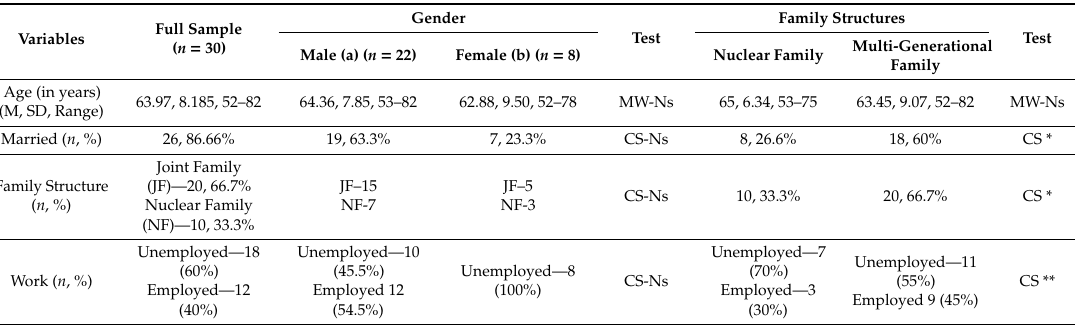
Table 1. Sample description.